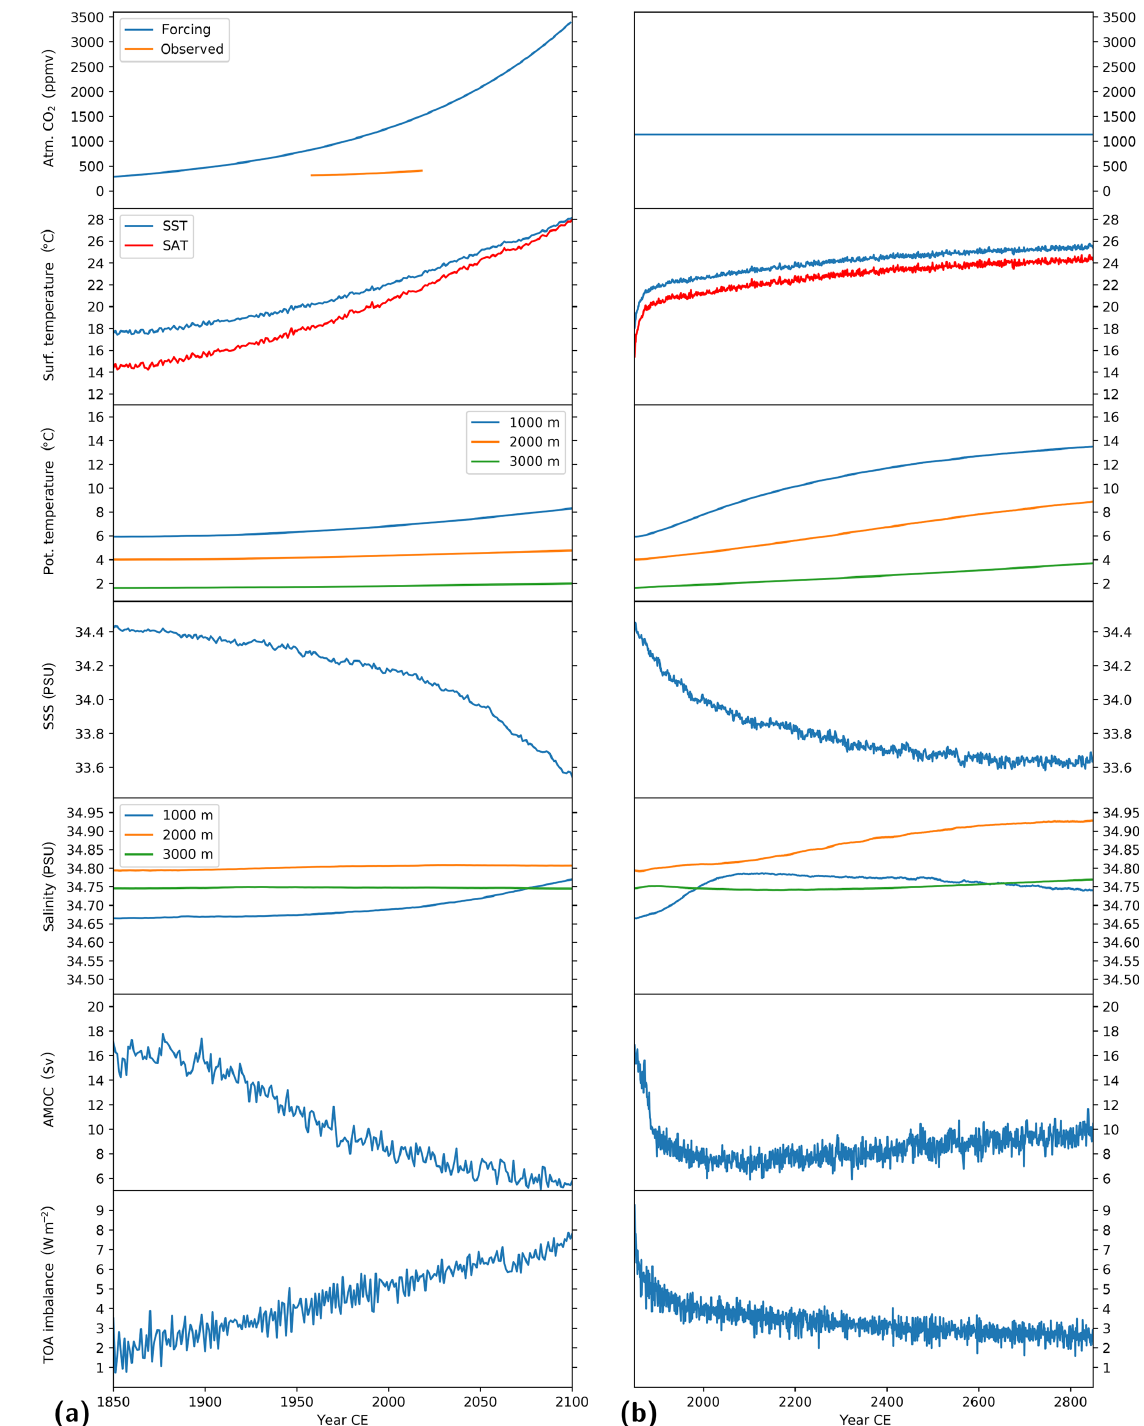
Figure 11. Time evolution of selected climate indices of CMIP6 simulations as a result of changes in carbon dioxide after initialisation from a CMIP6 PI control state (E280C): (a) 1pctCO2 and (b) abrupt4xCO2 (Eyring et al., 2016). Carbon dioxide forcing is shown in the uppermost graphs; observations by Keeling et al. (2001) are shown for reference in (a) . Surface air temperature (SAT) here refers to the surface skin temperature; sea surface temperature (SST) and sea surface salinity (SSS) represent the uppermost ocean layer (0–12m); Atlantic Meridional Overturning Circulation (AMOC) is the maximum stream function in the Atlantic Ocean north of 20 ◦ N and between 500 and 1500m; the top-of-atmosphere (TOA) radiative imbalance is computed from incoming and outgoing shortwave and longwave radiation at